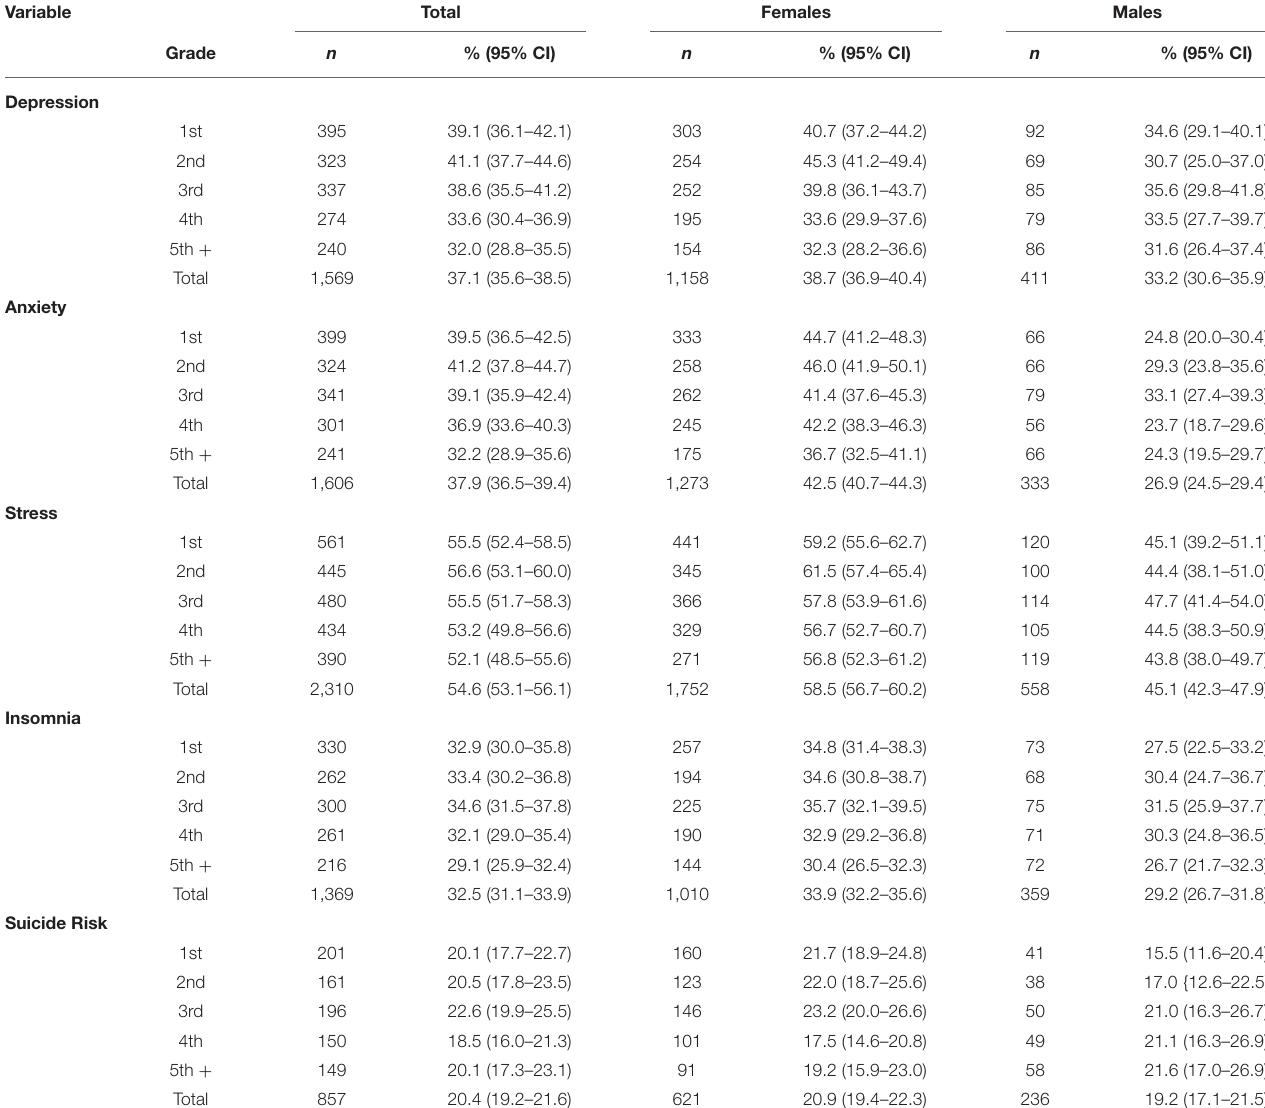
TABLE 6 | Psychological symptoms (DASS-21), insomnia, and suicide risk by sex and grade. Variable